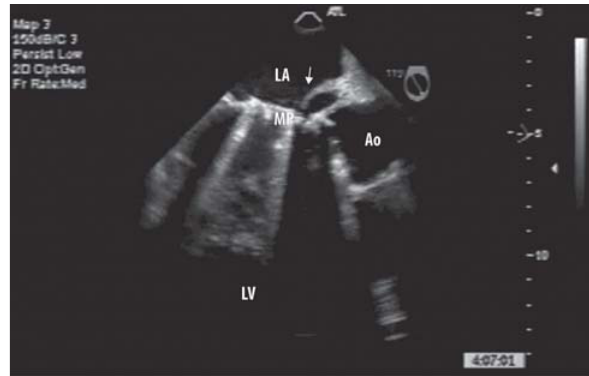
Fig. 2 - Transesophageal echocardiogram showing an